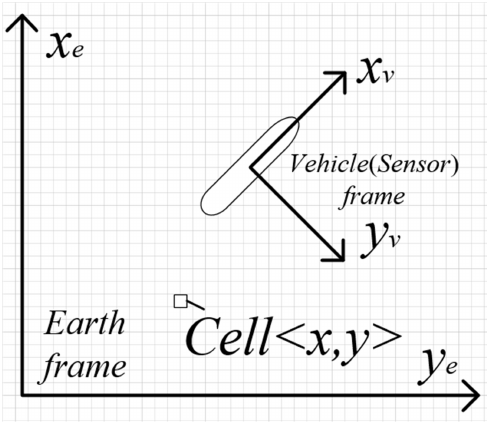
Figure 1. The workspace and the configuration of the